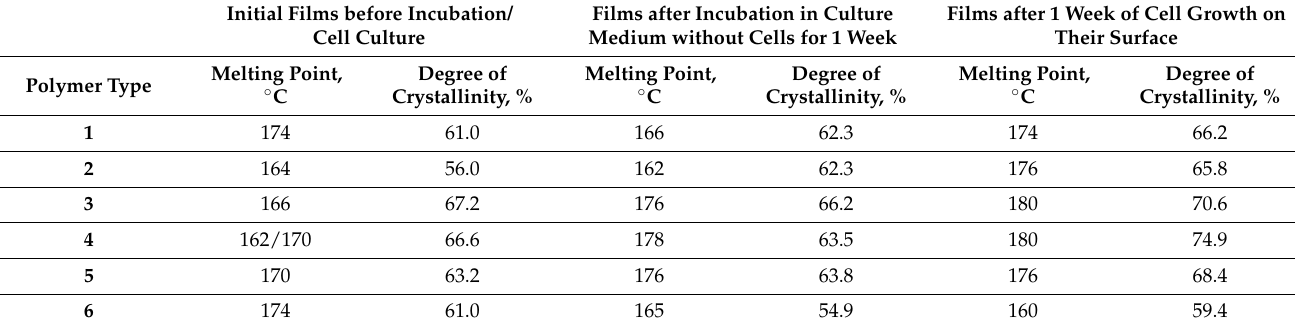
Table 1. Thermophysical characteristics of patterned films (1. PHB 350 kDa, 20 mg/mL concentration, 1 cm distance, 150 µ L volume; 2. PHB 350 kDa, 40 mg/mL concentration, 1 cm distance, 300 µ L volume; 3. PHB 180 kDa, 20 mg/mL concentration, 1 cm distance, 450 µ L volume; 4. PHB 1800